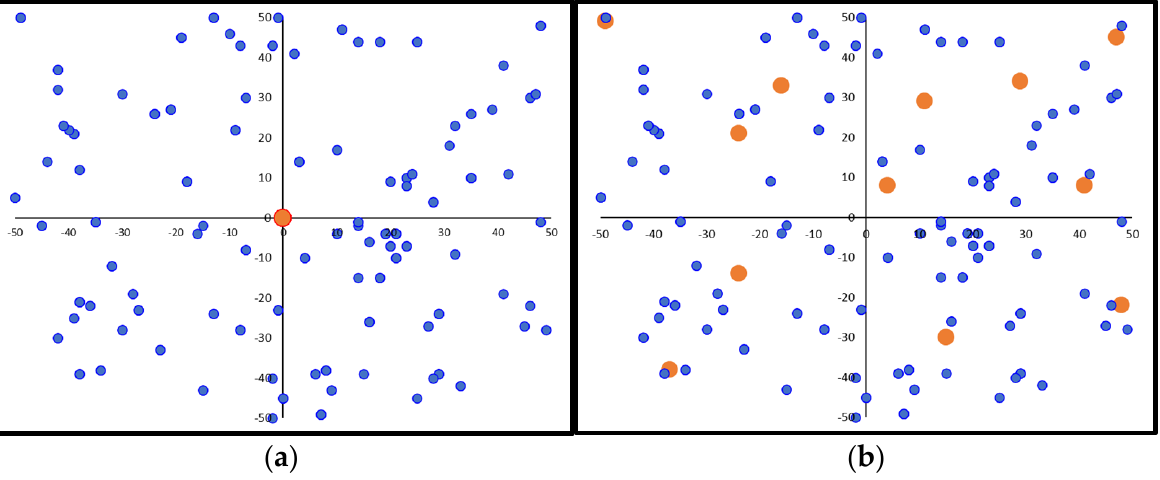
Figure 2. Demand scatter diagram (blue color) and charging station deployment (orange color) for the initial solution of the optimization: ( a ) center coordinates; ( b ) random distribution.